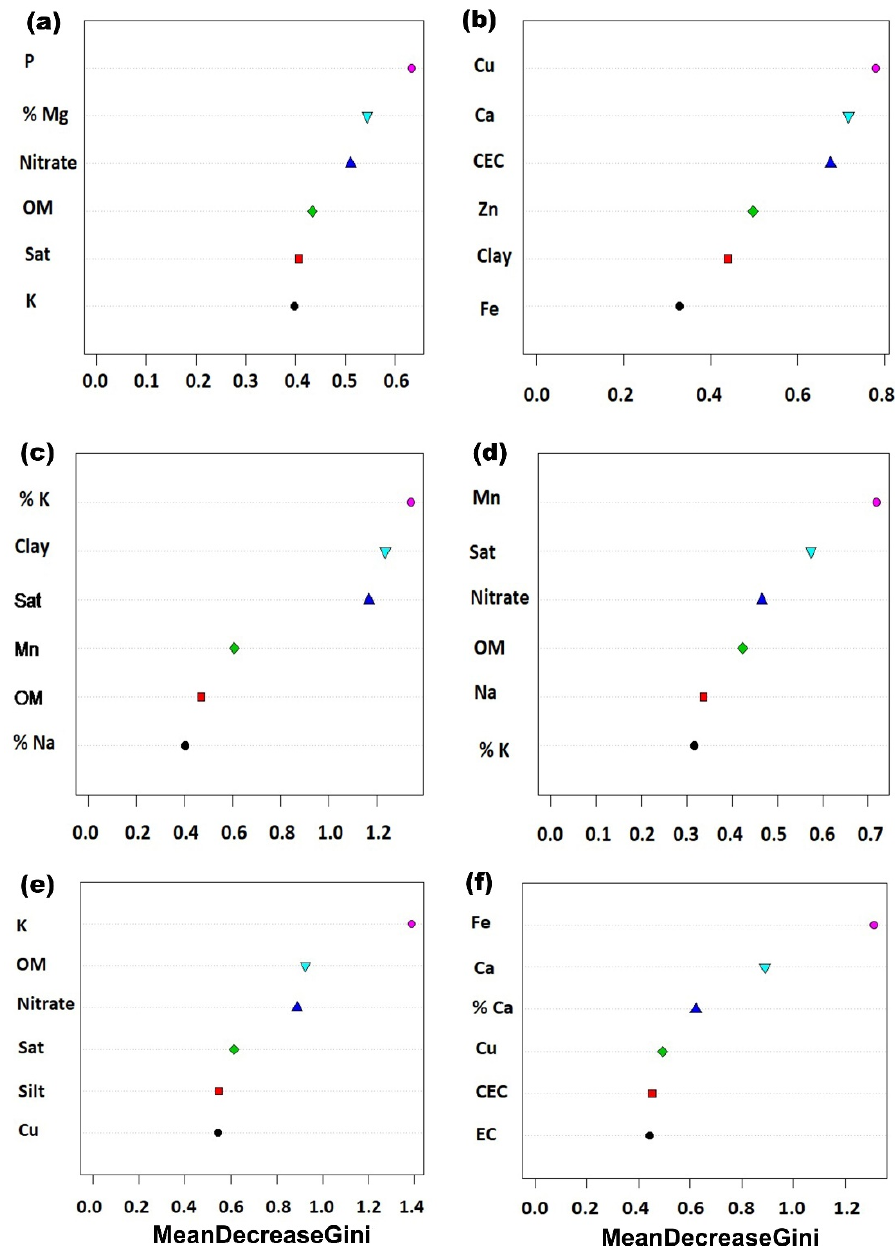
Figure 4. The six most important soil variables for the presence of species, detected by Random Forest are listed for presentation purposes. ( a ) Lupinus diehlii, ( b ) Commelina dianthifolia , ( c ) Acmispon wrightii, ( d ) Arctostaphylos pungens, ( e ) Agastache pallida ( f ) Ceanothus coeruleus. NO 3 : Nitrate (kg/ha), P: Phosphorus (ppm), Ca: Calcium (ppm), Na: Sodium (ppm), K: Potassium (ppm), Fe: Iron (ppm), Mn: Manganese (ppm), Cu: Copper (ppm), OM: Organic matter (%), Sat: Water saturation (%), Silt (%), Clay (%), %Ca: Relative proportion of Ca in CEC (%), %Mg: Relative proportion of Mg in CEC (%), %K: Relative proportion of K in CEC (%), %Na: Relative proportion of Na in CEC (%), CEC: Cation exchange capacity, EC: EC: Electrical conductivity (dS/m). For more information about parameter units see Tables S1 and S2. Table 4. Binomial logistic regression model coefficients for soil variables explaining the species presence under the canopy and in gaps. Species Estimate Std. Error p -Value ND RD AIC PoP Viola grahamii Intercept 33.91